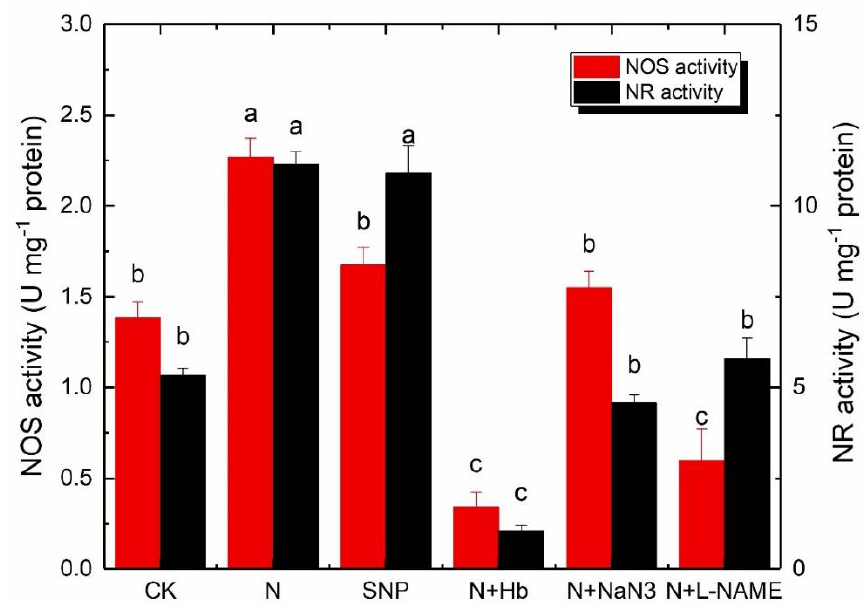
Figure 5. Effects of different ammonium/nitrate ratios, exogenous nitric oxide, and the addition of NO scavenger and biosynthesis inhibitors in ammonium/nitrate solution on NOS and NR activities of mini Chinese cabbage leaves exposed to low-light stress. Data represented means, and bars indicated the standard errors of the means ( n = 3). Significant differences ( p ≤ 0.05) between treatments were indicated by different letters, according to Tukey’s test.